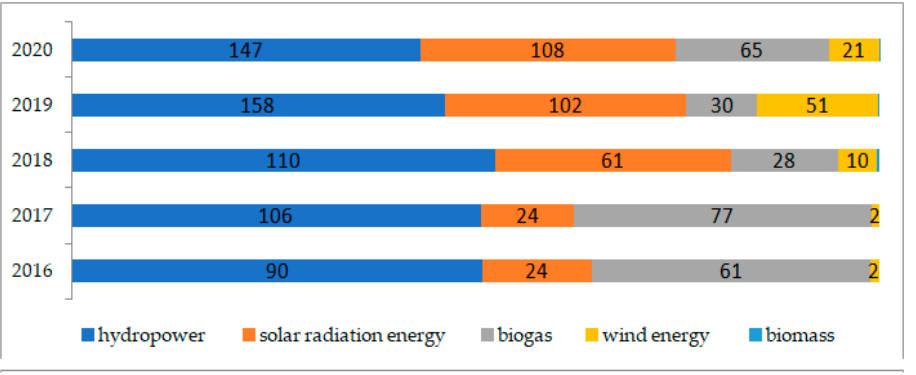
Figure 17. Renewable energy in 2016–2020 (GWh) [62].